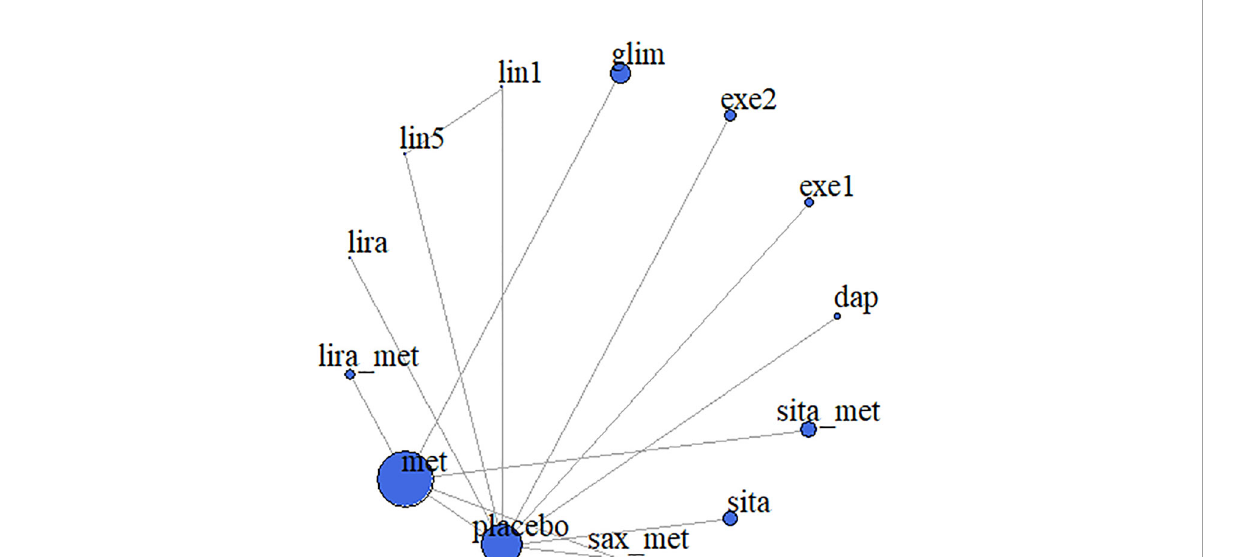
FIGURE 2 Meta-analysis networks for change in HbA1c. Each circle indicates a treatment node. Lines connecting 2 nodes represent direct comparisons between 2 treatments. The size of the nodes is proportional to the number of trials evaluating each treatment. The thickness of the lines is proportional to the number of trials directly comparing the 2 connected treatments. met, metformin; lira_met, liraglutide+metformin; lira, liraglutide; lin5, linagliptin-5 mg; lin1, linagliptin-1 mg; glim, glimepiride; exe1, exenatide-2 mcg; exe2, exenatide-5/10 mcg; dap, dapagli fl ozin; sita_placebo, sitagliptin+placebo; sita_met, sitagliptin_metformin; sax_met,